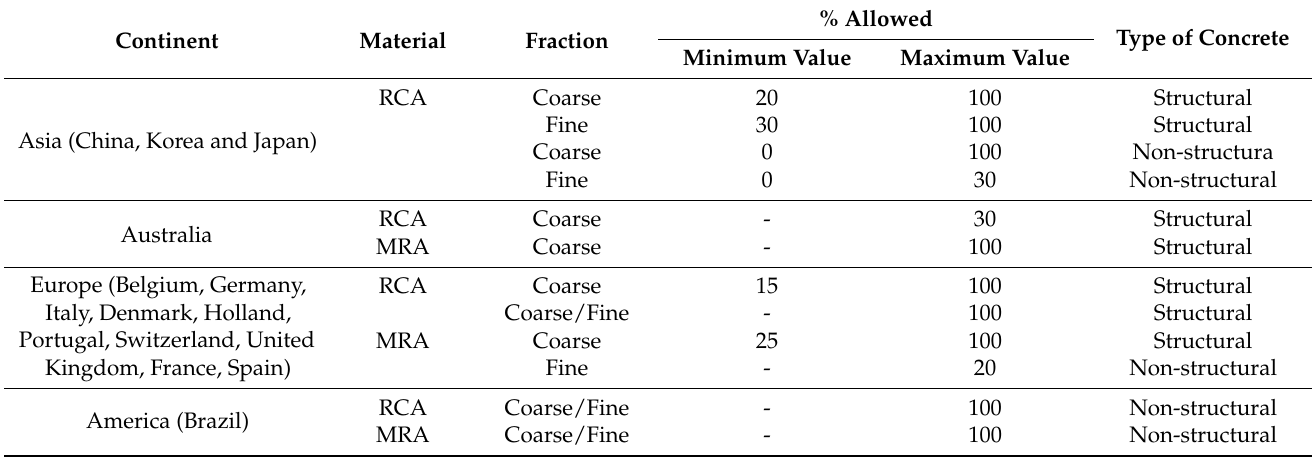
Table 1. Recycled aggregates in international regulation. Typology and maximum rate of incorporation. Continent Material Fraction